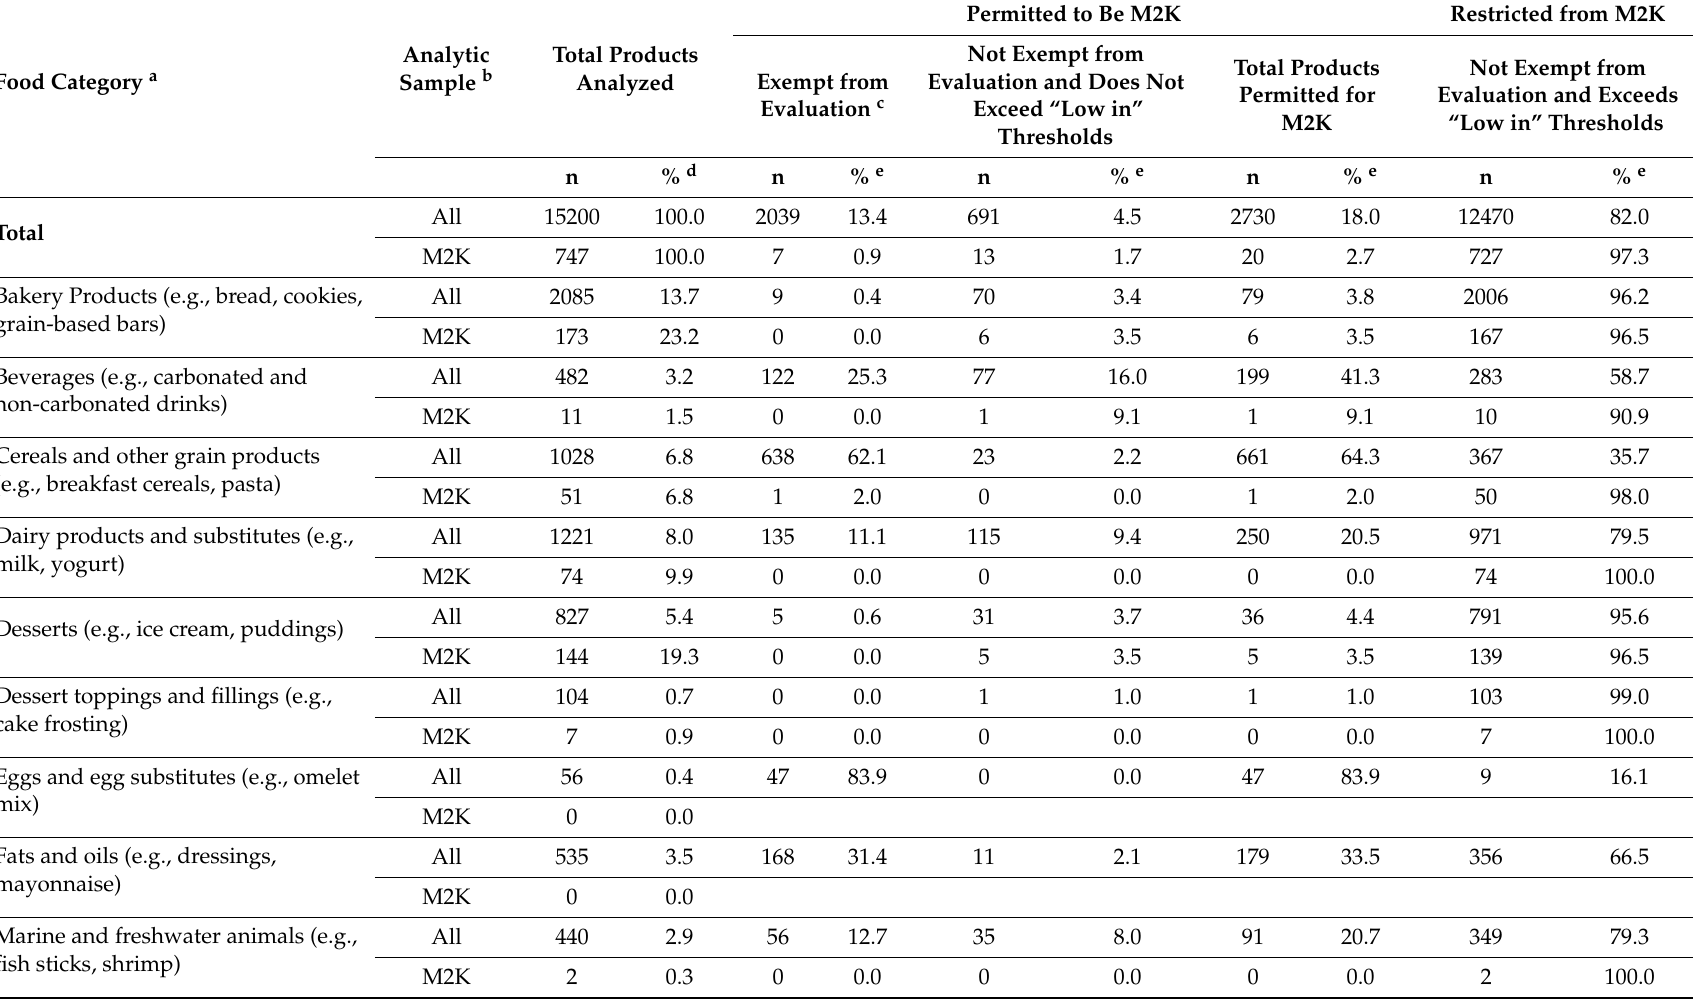
Table 2. Number (n) and proportion (%) of products that would be permitted or restricted from marketing to children